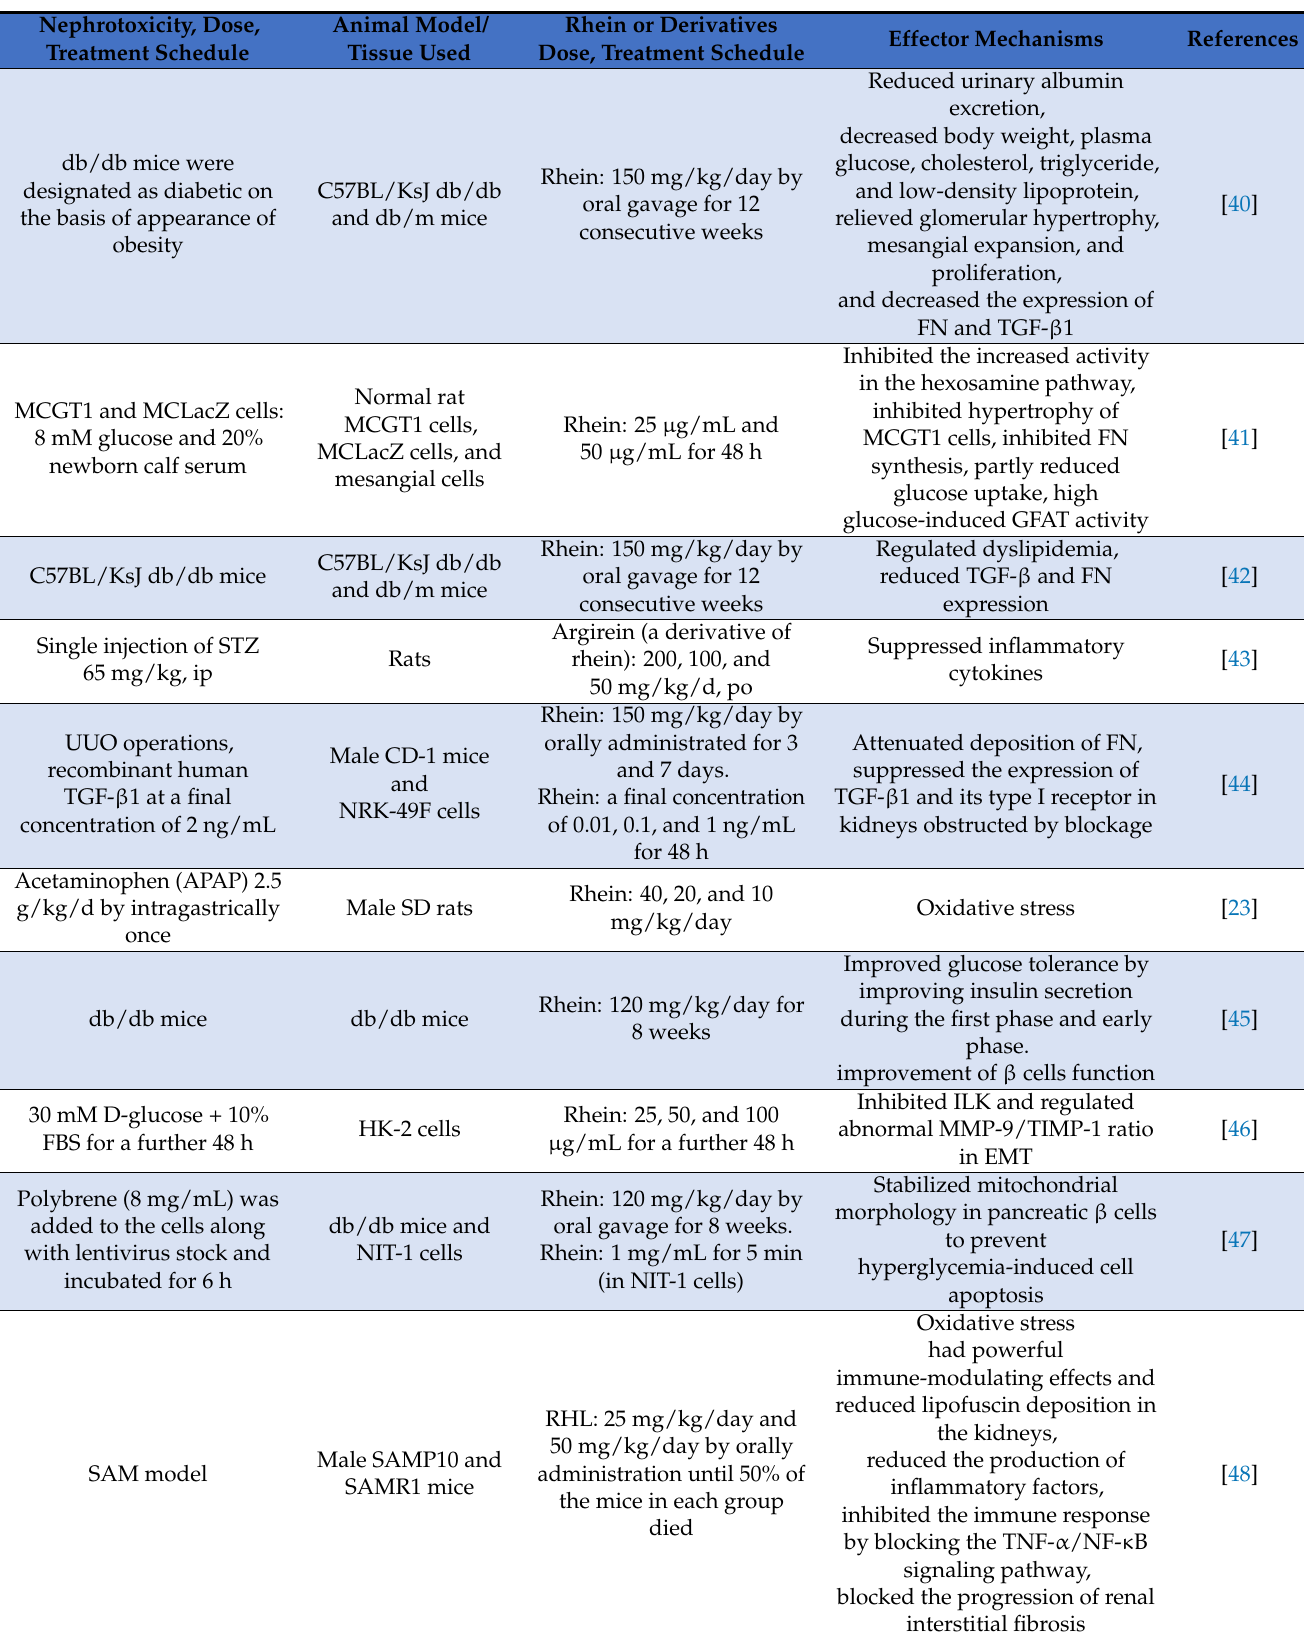
Table 1. Nephroprotective effects of rhein, its derivatives, and its mechanisms of